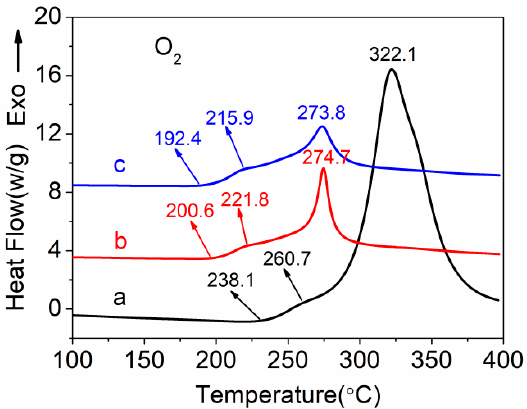
Figure 7. DSC curves of ( a ) PAN homopolymer, ( b ) PAN-IA0.5 copolymers, and ( c ) PAN-IA1.0 copolymers in an air atmosphere.